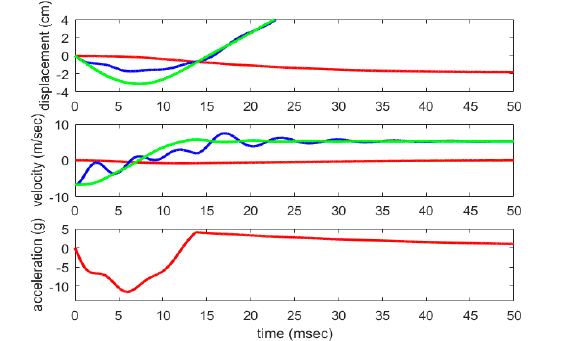
Figure 2. The effect of a ball pumped to 10 psi on the displacement of ball (blue and green) and head (red), the velocity of ball (blue and green) and head (red), and the acceleration of a head for a male heading a soccer